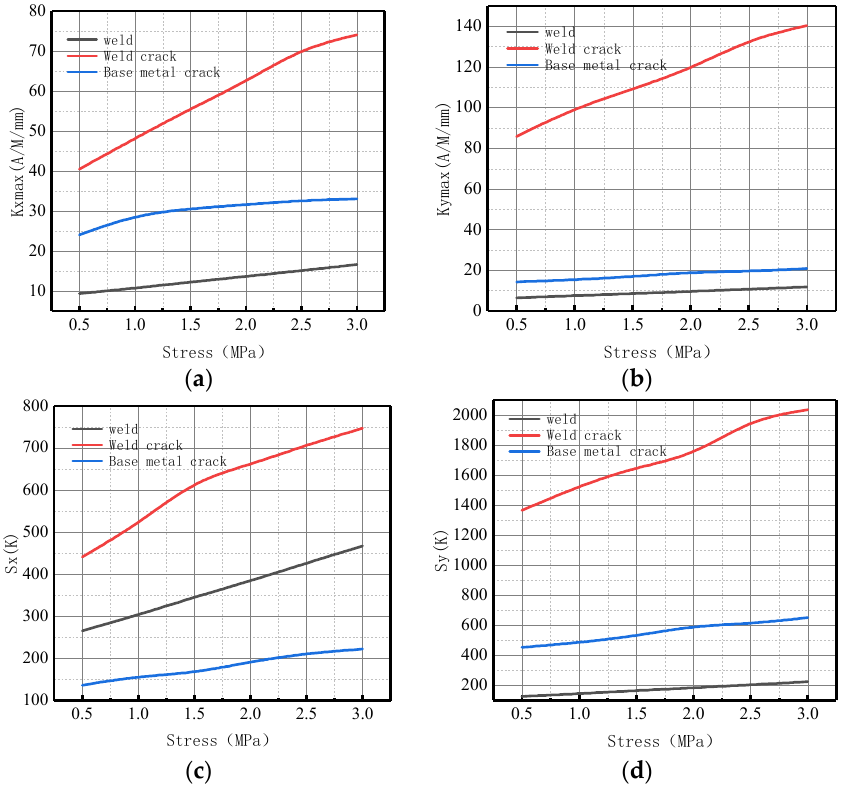
Figure 22. Variations of Kmax and S ( K ) parameters calculated by simulation under three conditions. ( a ) Axial component of Kmax ; ( b ) radial component of Kmax . ( c ) Axial component of S ( k ); ( d ) radial component of S ( k ).